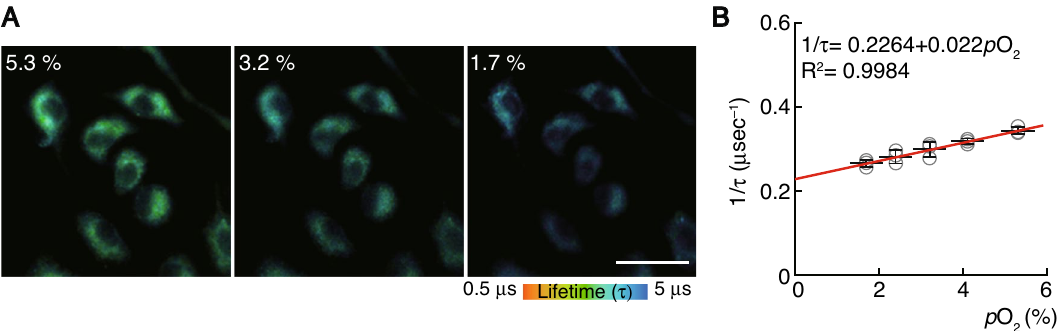
Figure 2. Reciprocal plot of phosphorescence lifetime and oxygen concentration. ( A ) Two-photon phosphorescence lifetime imaging microscopy (2PLIM) images of in vitro-cultured bone marrow-derived monocytes/macrophage precursor cells (BMMs) under different conditions of oxygen concentration. Scale, 20 μm. ( B ) The phosphorescence quenching due to dissolved oxygen in culture media can be examined by the Stern–Volmer equation. The approximate line was constructed by a straight-line approximation, and an approximation formula and the coefficient of determination are